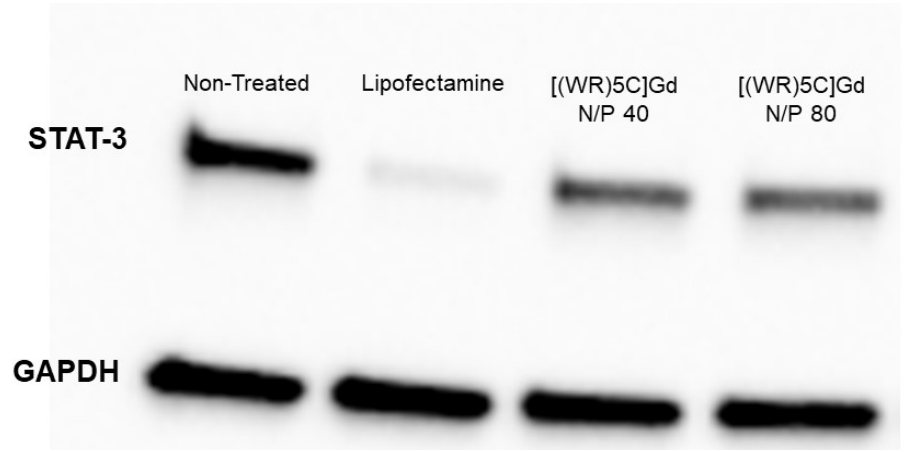
Figure 7. STAT-3 expression in the MDA-MB-231 cells treated with siRNA loaded with [(WR) 5 C]- GdNPs at N/P 40 and N/P 80 using western blot. GAPDH serves as a negative control, NT reflects nontreated cells, and lipofectamine serves as a positive control. Lipofectamine is one of the widely used transfection agents that was used in comparative assays with [(WR) 5 C]-GdNPs.